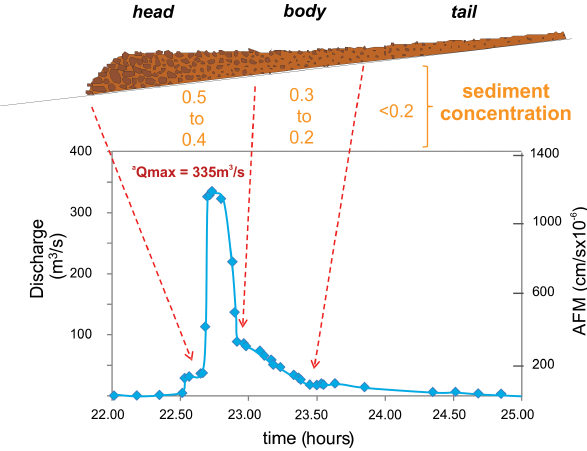
Figure 4. Geophone data used to reconstruct the hydrograph of the 2001 lahar. Q max used to calibrate geophone data was obtained by Muñoz-Salinas et al. (2007). Left scale refers to the flow discharge (m 3 s − 1 ), and the right scale AFM units. In the upper part, sedi- ment concentration for each portion of the hydrograph is indicated. Geophone data are from